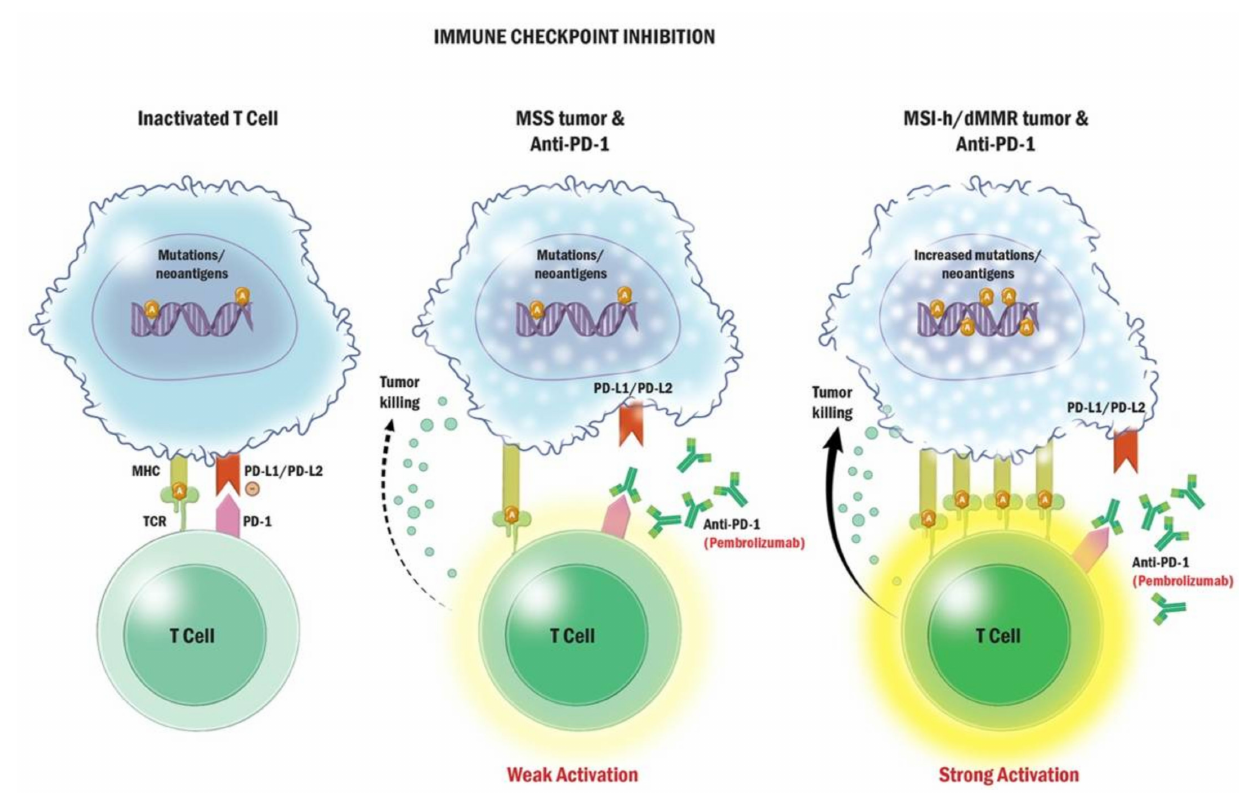
Figure 4. Mechanism of Action of Immunotherapy. Tumors highly express PD-L1 on their cell surface as a mechanism of camouflaging themselves from attack from the immune system. When PD-1 on T cells binds to its ligand PD-L1 on tumor cells, it sends an inhibitory signal to the T-cell, disguising itself as healthy tissue. In the presence of PD-1 checkpoint inhibitors, this interaction is blocked, allowing for T cell activation and recognition of the tumor cell as foreign, resulting in cytotoxic cell death. When tumors have high mutational burdens (TMB) or high microsatellite instability (MSI-H), they generate more neoantigen protein strands from mutations on the DNA strands (represented by an orange circle with the letter “a”). These antigens are then presented to the T cell resulting in stronger activation of T cell in the presence of PD-1